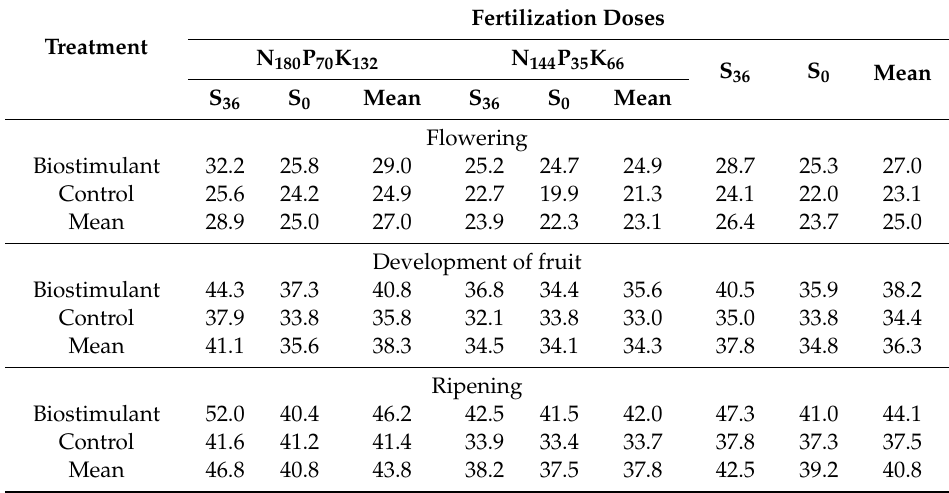
Table 4. Accumulation of P in shoots of rapeseed in generative development stages depending